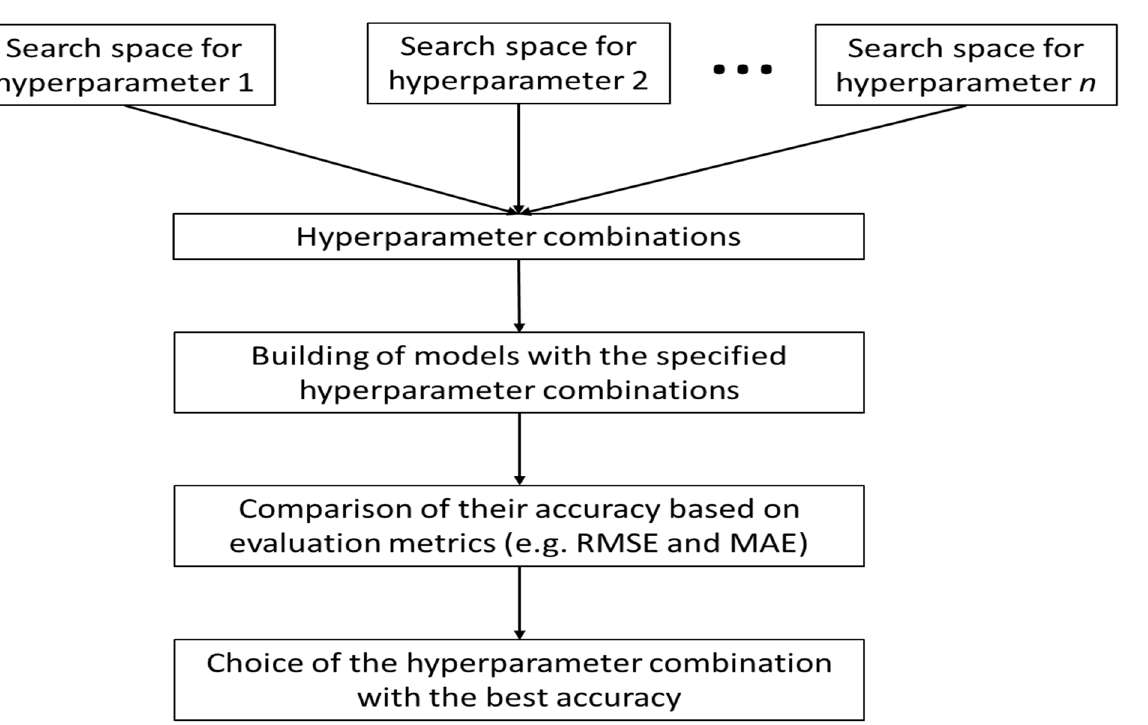
Figure 9. Hyperparameter